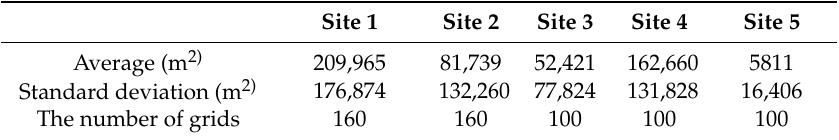
Table 2. The average and standard deviation of landslide area with the grids in each